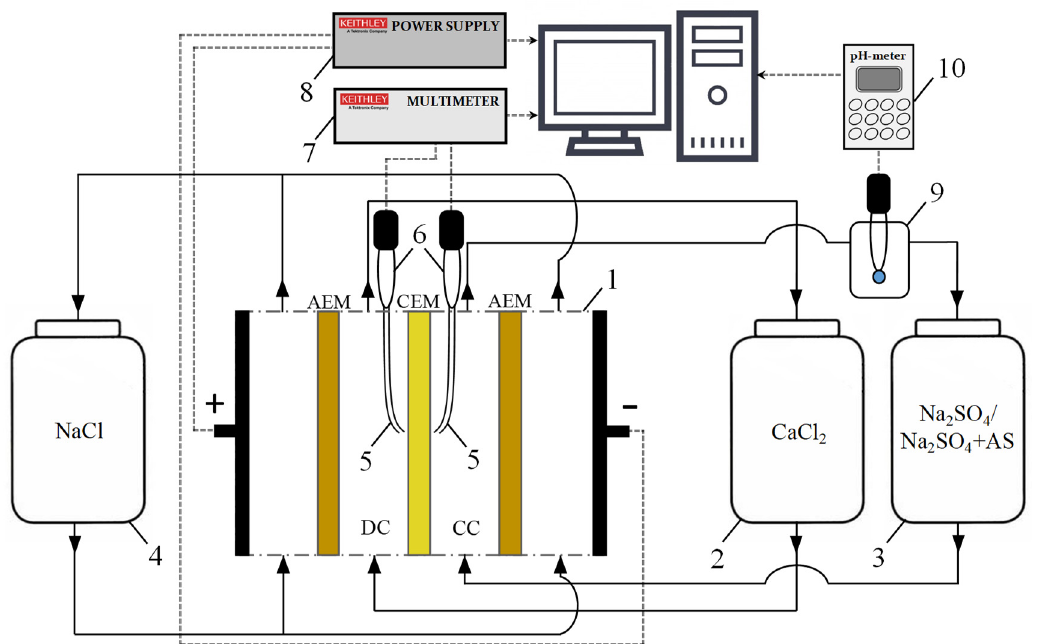
Figure 2. Principal scheme of the experimental setup: electrodialysis cell (1), consisting of one concentration, one desalination and two electrode compartments; solution tanks (2, 3, 4); Luggin’s capillaries (5), connected with silver chloride electrodes (6); Keithley 2010 multimeter (7); Keithley 2200-60-2 power supply (8); and flow pass cell with pH combined electrode (9), connected with pH-meter Expert 001